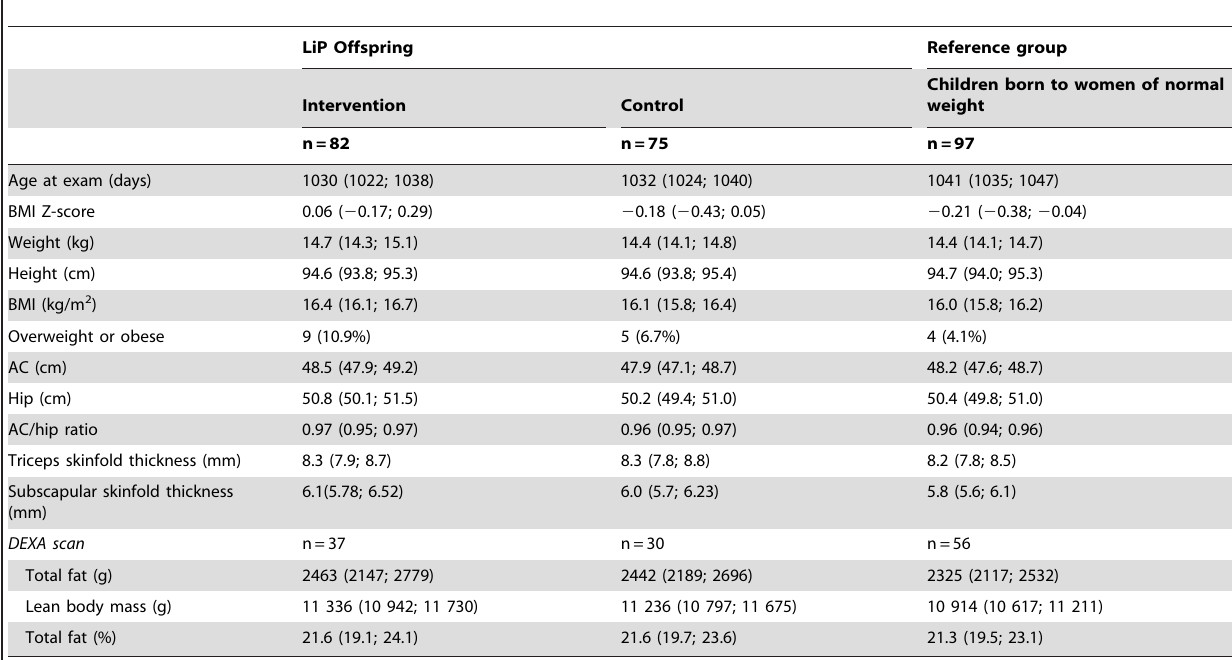
Table 2. Anthropometric outcomes and body composition according to LiP intervention and reference groups in 2.8 year old children.